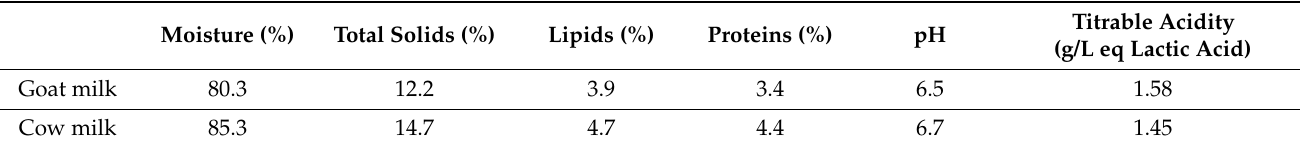
Table 1. Physico-chemical characteristics of raw goat milk used in this study, in comparison with raw cow